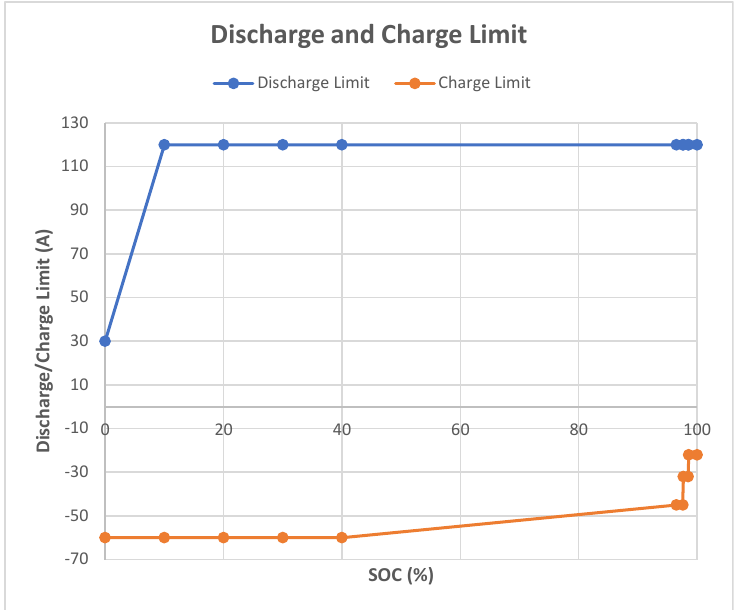
Figure 6. Discharge and charge current limits (in Ampere) vs. the State of Charge (SOC) of the battery pack.